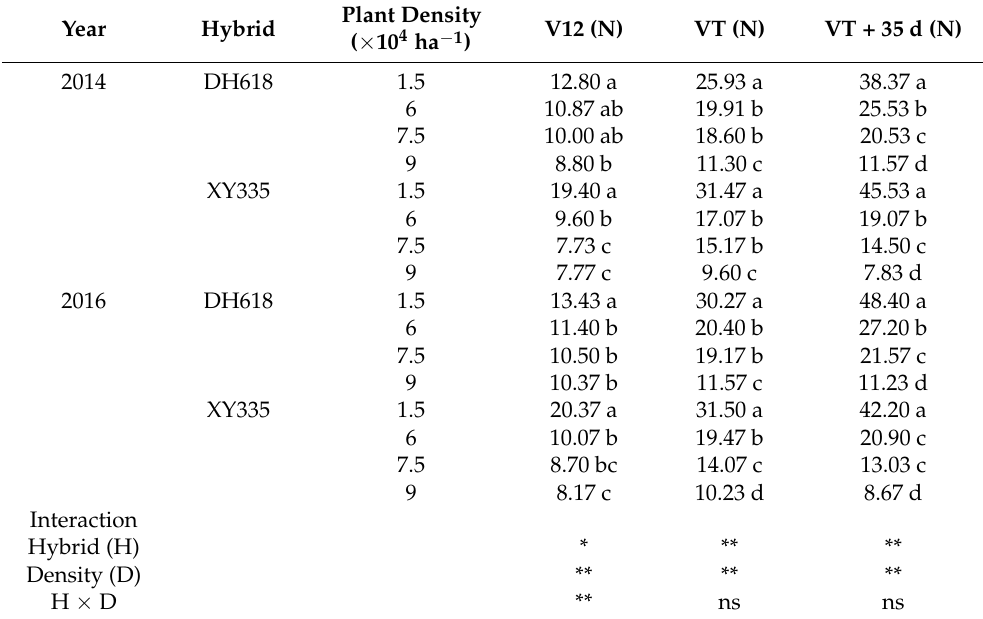
Figure 1. Field lodging rate of DH618 and XY335 under different planting densities in 2014 and 2016. * Significant difference at p < 0.05.